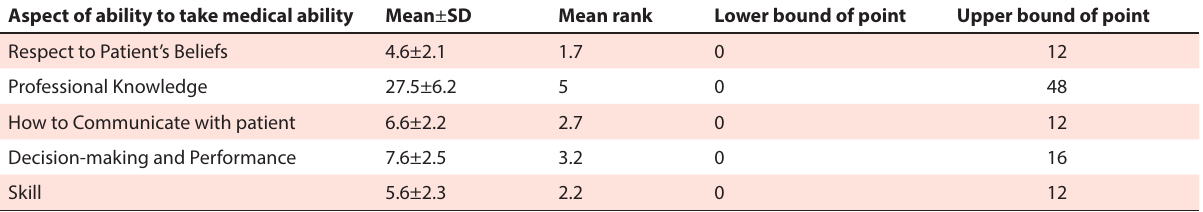
Table 2. The average distribution of the ability to take medical history of patients in medical emergency in Golestan province EMS based on importance in 2015 Aspect of ability to take medical ability Mean ± SD Mean rank Lower bound of point Upper bound of point Respect to Patient’s Beliefs 4.6±2.1